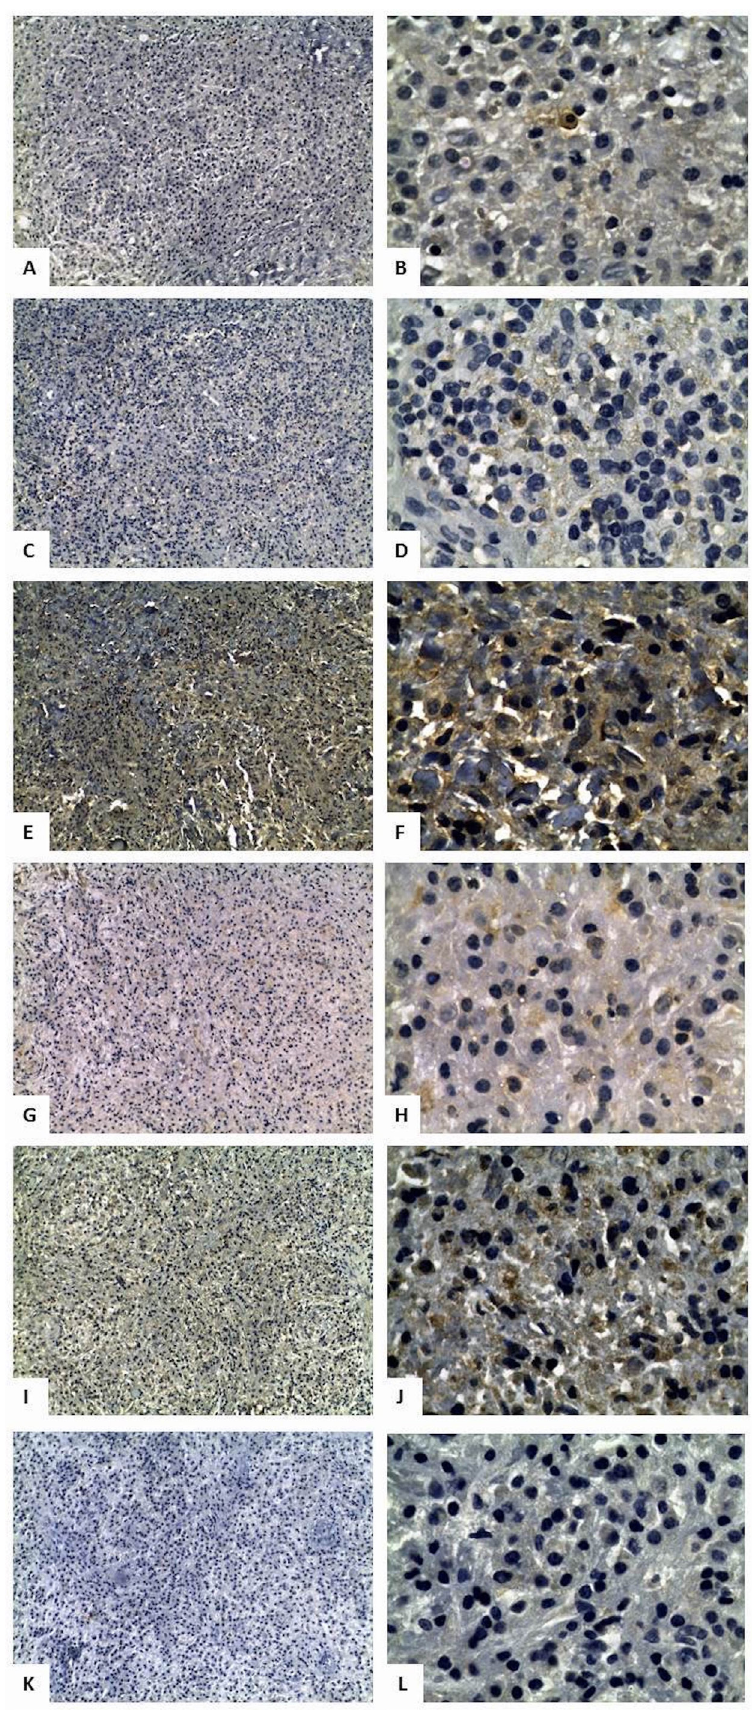
Figure 1- Apical periodontitis specimens with positive staining for pro-inflammatory and anti-inflammatory cytokines. A, IFN-γ (200x); B, IFN-γ (1000x); C, IL-1β (200x); D, IL-1β (1000x); E, IL-4 (200x); F, IL-4 (1000x); G, IL-6 (200x); H, IL-6 (1000x); I, TGF-β (200x); J, TGF-β (1000x); K, TNF- α (200x); L, TNF- α